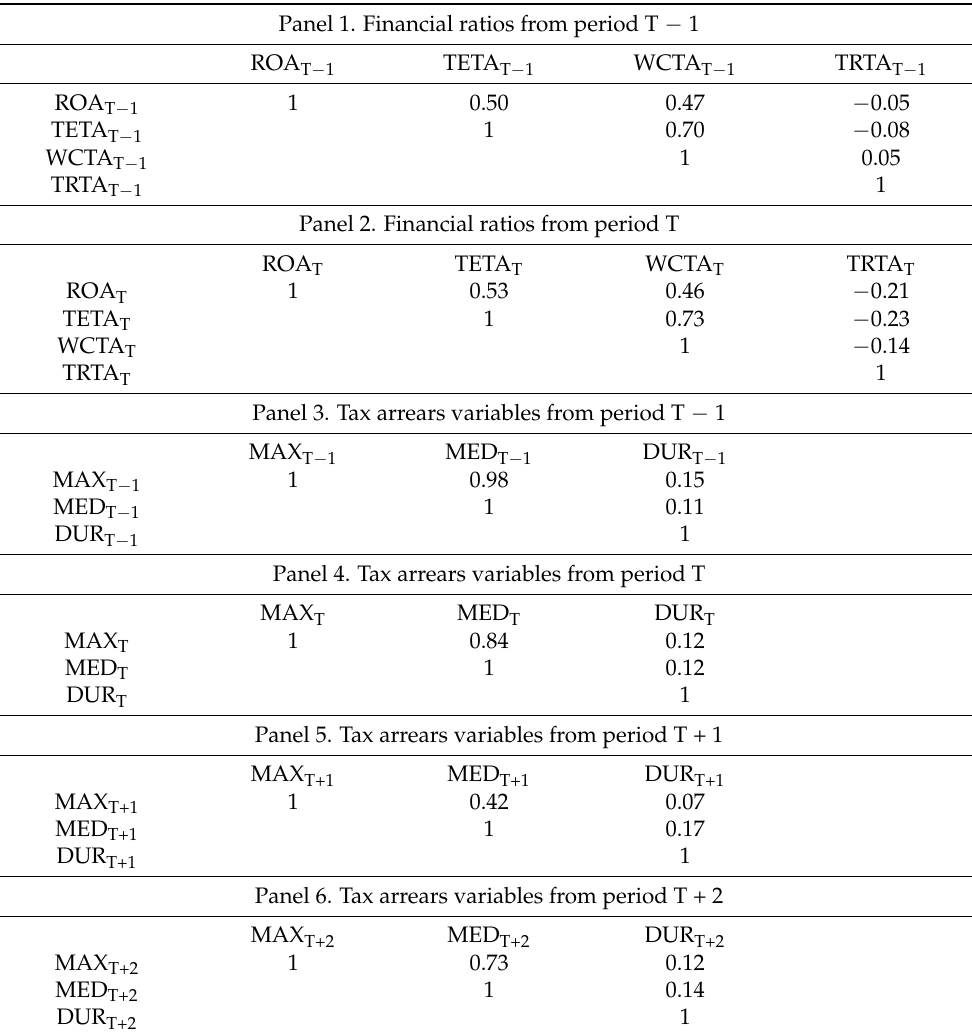
Table A1. Correlation tables of variables in six individual